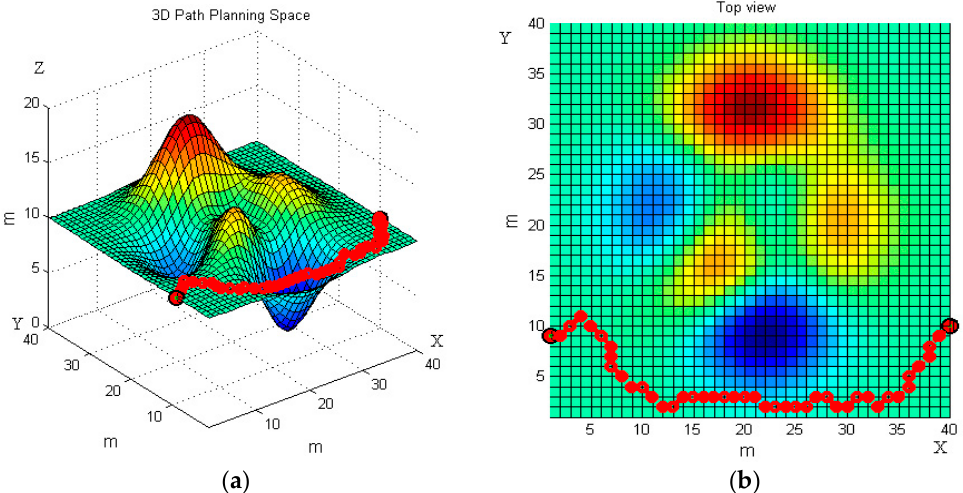
Figure 7. The robot’s moving trajectory using the basic ant colony algorithm in the first terrain. ( a ) Front view; and ( b ) top view.